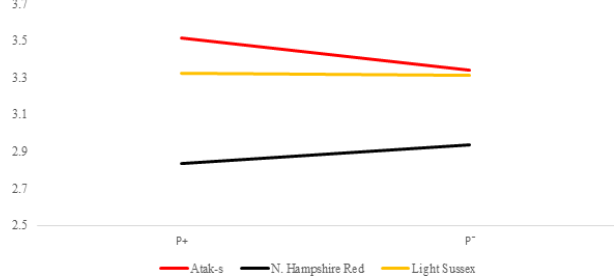
Figure 5. Averages of feed conversion ratio for infested (P + ) and non-infested (P − ) groups in ad libitum conditions (AL); feed g / LWg.